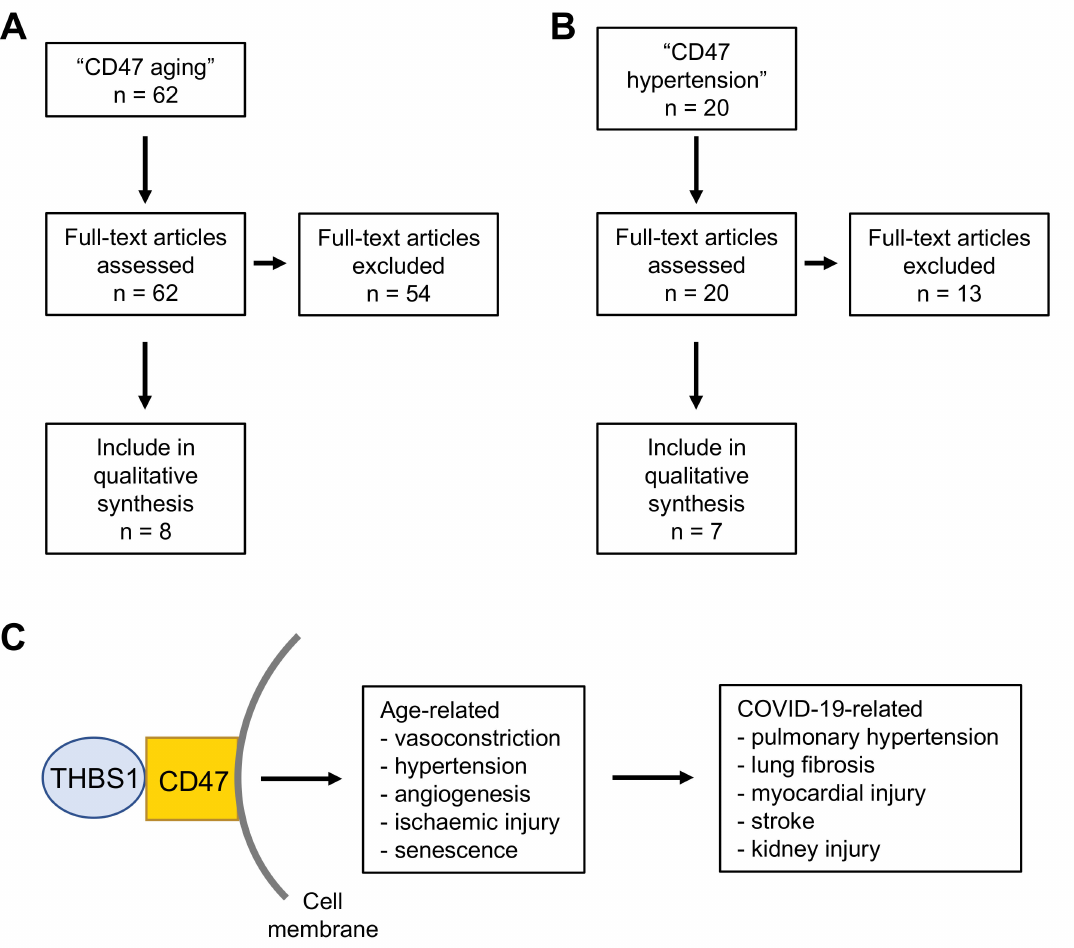
Figure 3. Results of the PubMed (https://pubmed.ncbi.nlm.nih.gov accessed on 17 February 2021) literature search for “CD47 aging” ( A ) and “CD47 hypertension” ( B ). ( C ) Overview figure of the data derived from the literature searches. Age-related increased CD47 levels may contribute to pathogenic conditions associated with severe